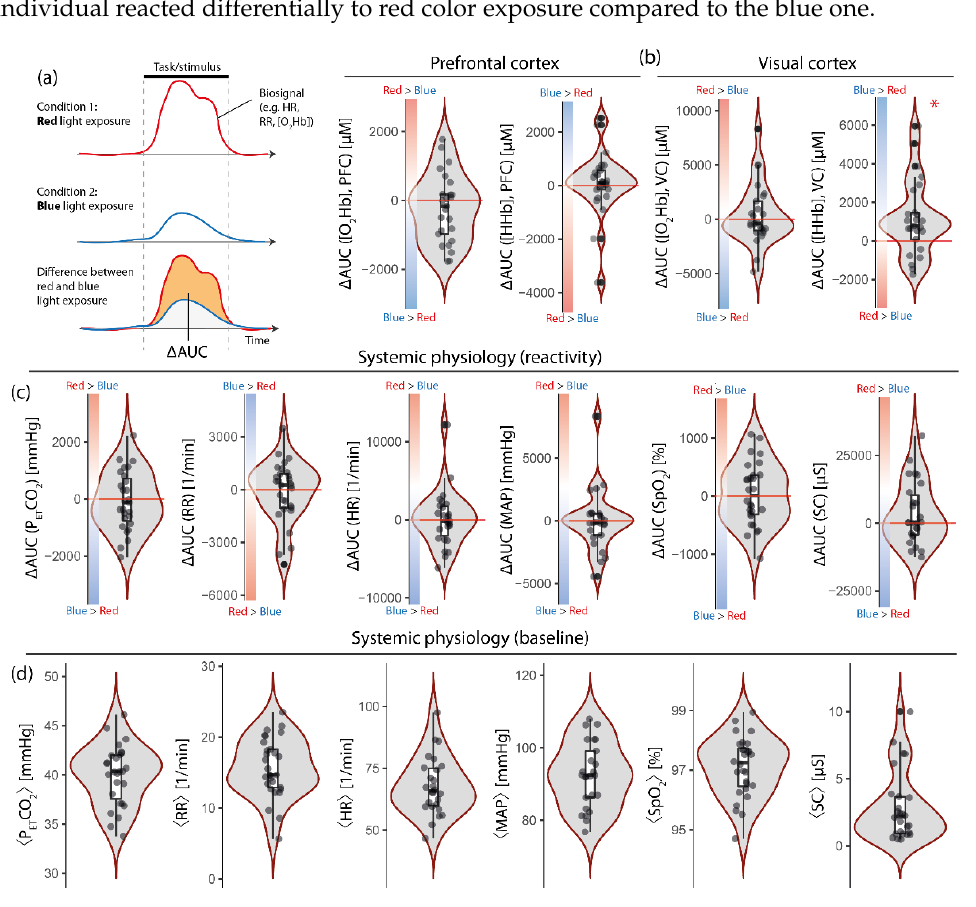
Figure 1. ( a ) Illustration of the calculation of AUC values of the biosignals. ( b ) ∆AUC values for fNIRS biosignals were measured over the prefrontal and the visual cortex. ( c ) ∆AUC values for systemic physiological signals. ( d ) Baseline values (resting-state) for systemic physiological signals. Note: Positive values of ∆ AUC correspond to a stronger response of the respective biosignal to the red color exposure compared to the blue one (and vice versa). The ∆AUC and mean values are vis- ualized as box plots with density functions and single data values for each subject added. Asterisk indicates p < 0.05 compared to a distribution around zero.